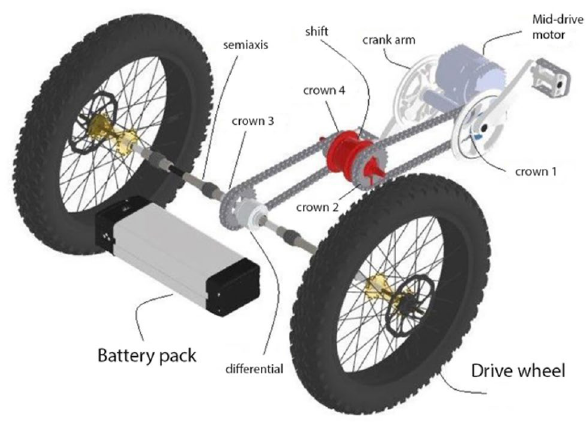
Fig. 8 Mid-drive type powertrain chosen for SNAP